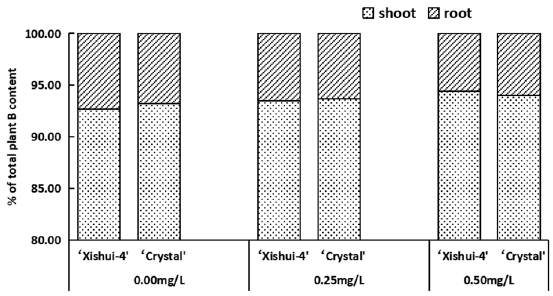
Figure 5. Effects of B-deficiency on B distribution proportion of two grape genotypes.